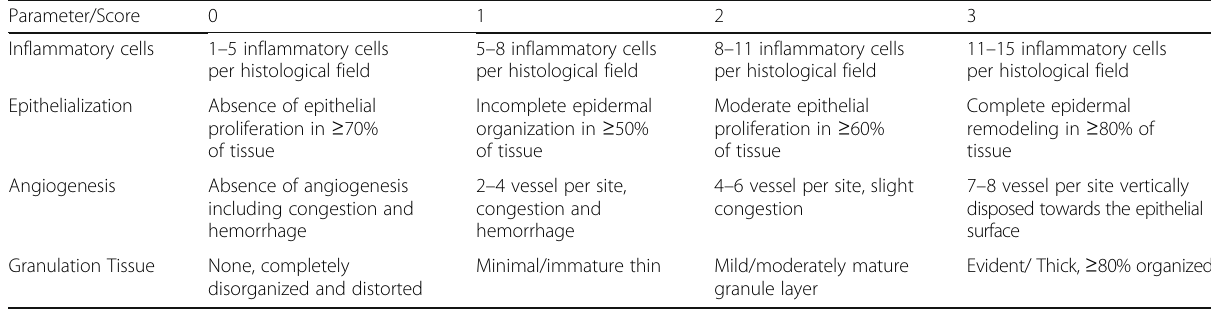
Table 1 Histological scoring parameter of epithelialization, angiogenesis, granulation tissue formation, and inflammatory cells